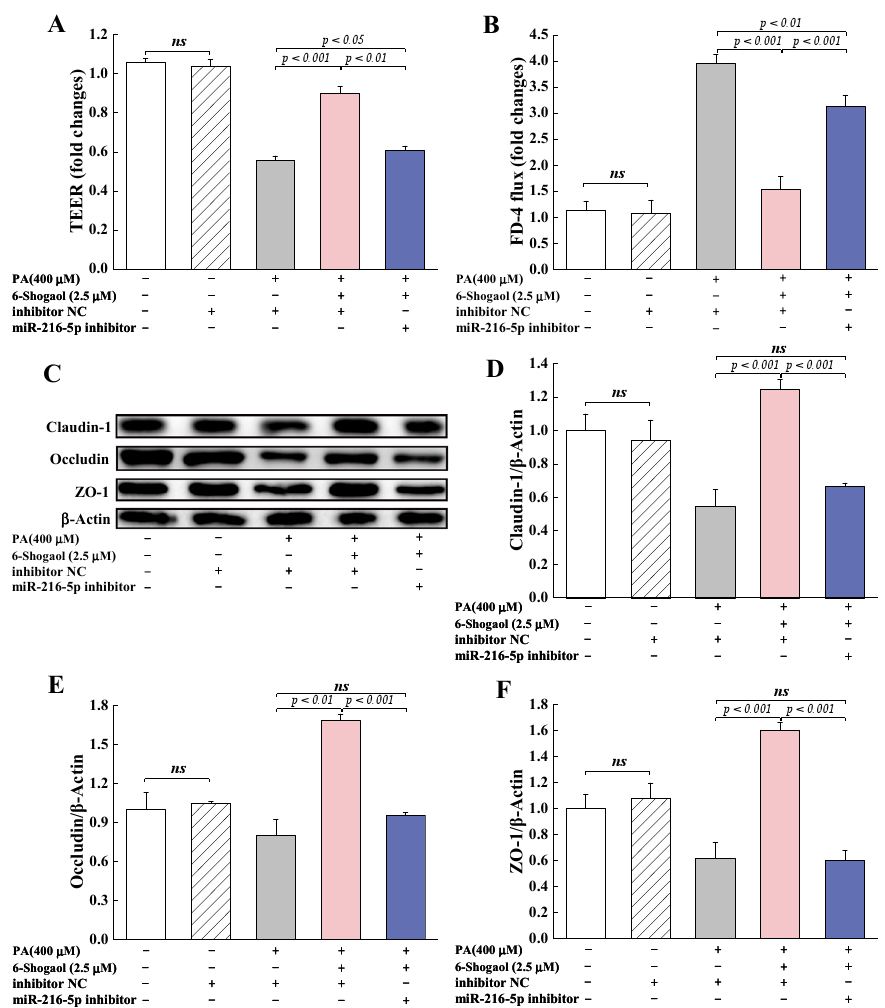
Figure 7. MiRNA-216a-5p mediated the protection provided by 6-shogaol against PA-induced TJ disruption: ( A ) Effect of miRNA-216a-5p on TEER in Caco-2 monolayers; ( B ) Effect of miRNA-216a-5p on FD-4 flux in Caco-2 monolayers; ( C ) Representative immunoblotting of TJ-associated proteins in Caco-2 cells transfected with miRNA-216a-5p inhibitor; ( D – F ) Effects of miRNA-216a-5p on the expression of claudin-1, occludin, and ZO-1 proteins in Caco-2 cells. Data are given as means ± standard deviations (n = 3). ns indicates no significant difference at p < 0.05.